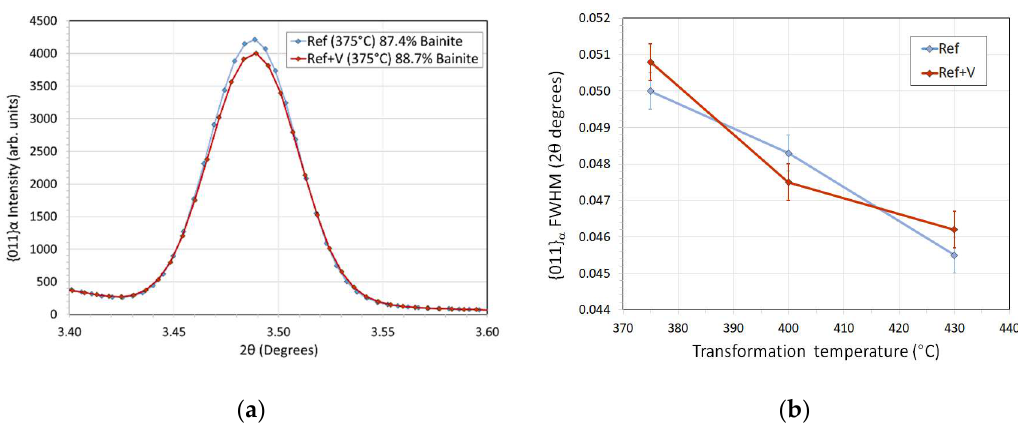
Figure 5. ( a ) HEXRD {011} α reflection for Ref and Ref + V transformed for 600 s at 375 ◦ C. ( b ) Comparison of {011} α peak broadening for Ref and Ref + V transformed for 600 s at 375 ◦ C, 400 ◦ C and 430 ◦ C.